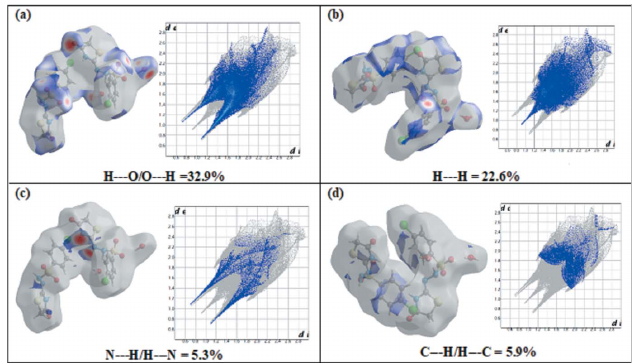
Figure 4 The two dimensional fingerprint (FP) plot for the title compound, delineated into ( a ) O (cid:2)(cid:2)(cid:2) H/H (cid:2)(cid:2)(cid:2) O, ( b ) H (cid:2)(cid:2)(cid:2) H, ( c ) N (cid:2)(cid:2)(cid:2) H/H (cid:2)(cid:2)(cid:2) N and ( d ) C (cid:2)(cid:2)(cid:2) H/H (cid:2)(cid:2)(cid:2) C interactions. d norm surfaces for each plot indicating the relevant surface patches associated with the specific contacts are shown on the left.